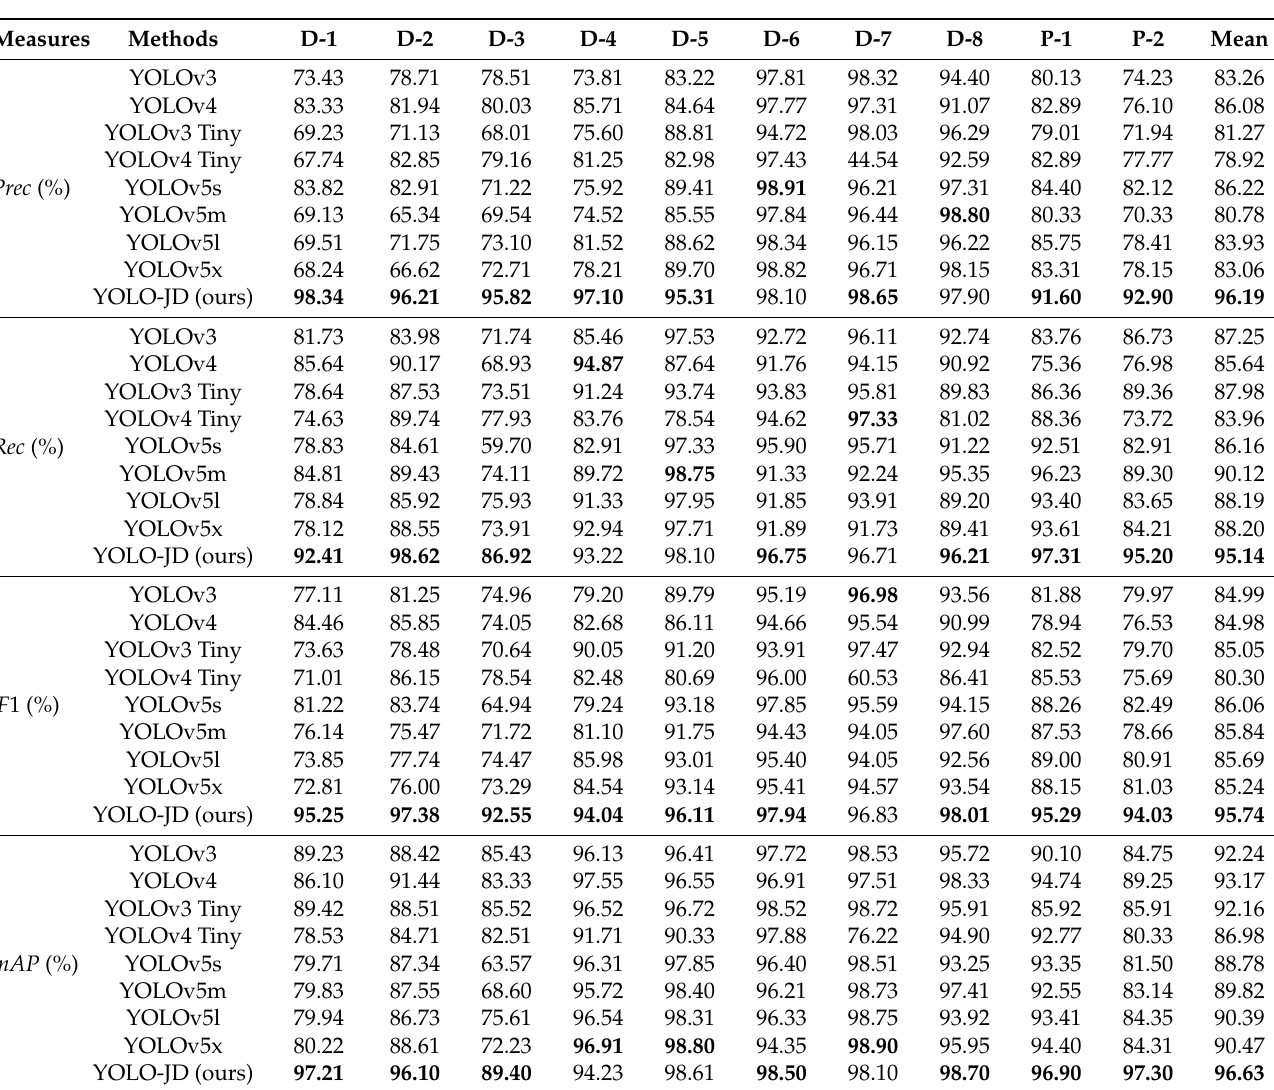
Table 2. The quantitative comparison of several methods including YOLO-JD on the Jute disease test dataset. The best measures are in